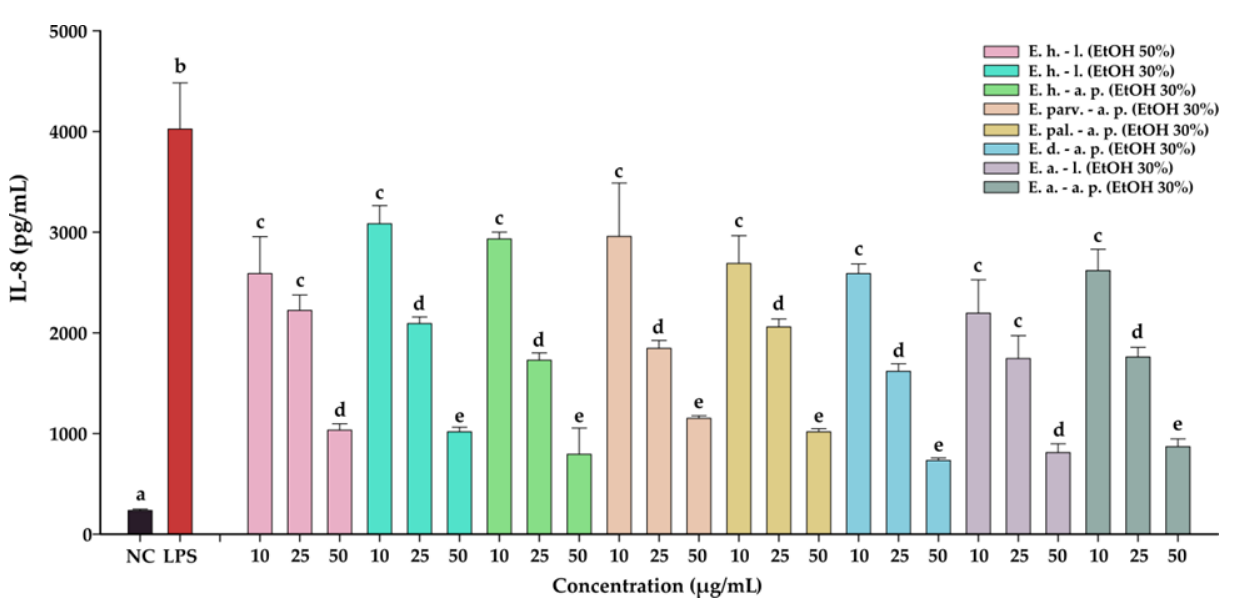
Figure 7. The anti-inflammatory potential of E. hirsutum leaves EtOH 50% (E. h. – l.), E. hirsutum leaves EtOH 30% (E. h. – l.), E. hirsutum aerial parts EtOH 30% (E. h. – a.p.), E. parviflorum aerial parts EtOH 30% ( E. parv. – a. p.), E. palustre aerial parts EtOH30% (E. pal. – a. p.), E. dodonaei aerial parts EtOH 30% (E. d. – a. p.), E. angustifolium leaves EtOH 30% (E. a. – l.), and E. angustifolium aerial parts EtOH 30% (E. a. – a. p.). The quantity of IL-6 was measured from cellular supernatants after a 24 h exposure to the extracts (10, 25, and 50 µg/mL) in combination with 100 ng/mL LPS. Different lowercase letters for bars representing the same extract and shown in identical colors indicate statistically significant differences in measured cytokine amounts (ANOVA + Holm– Sidak post hoc test at p < 0.05 level of significance).